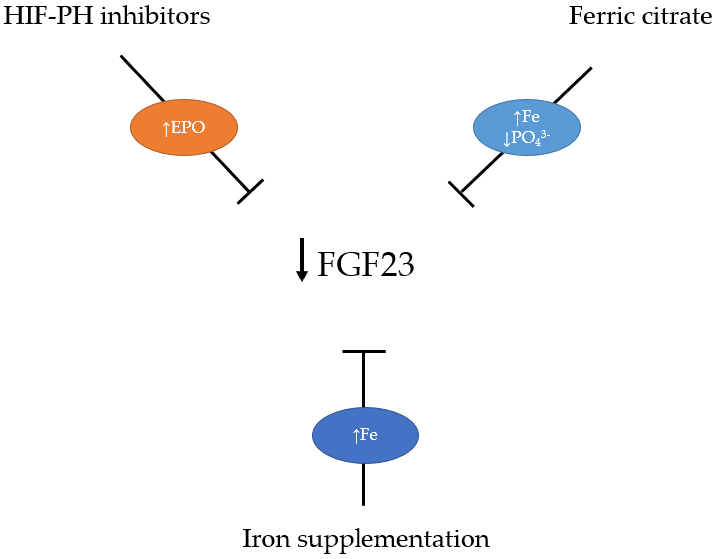
Figure 3. Therapeutic approach for FGF23 lowering in chronic kidney disease. Abbreviations: EPO—erythropoietin, HIF ‐ PH—hypoxia ‐ inducible factor prolyl hydroxylase, Fe—iron, PO 43 − — phosphate.